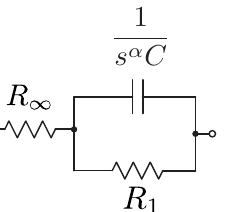
Figure 1. Fractional-order equivalent circuit model, also known as the Cole-impedance model, to represent the frequency-dependent impedance of biological